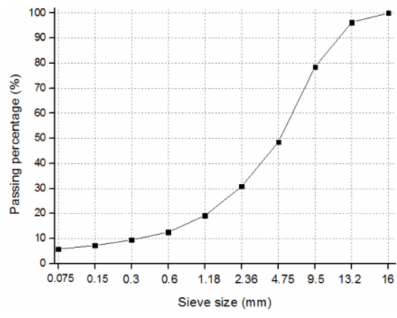
Figure 1. Gradation curve.